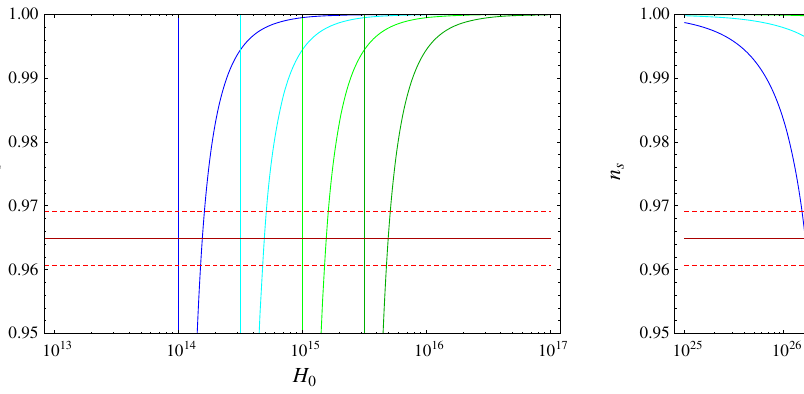
Fig. 3 The spectral index n S with respect to H 0 the left, and to H 1 in the right, for N = 50 and γ = b = 1 and μ = 1s − 1 . The plots are identical for N = 60 and any other values of γ , b and μ . The blue, cyan, green and darker green curves correspond to different values of H 1 and